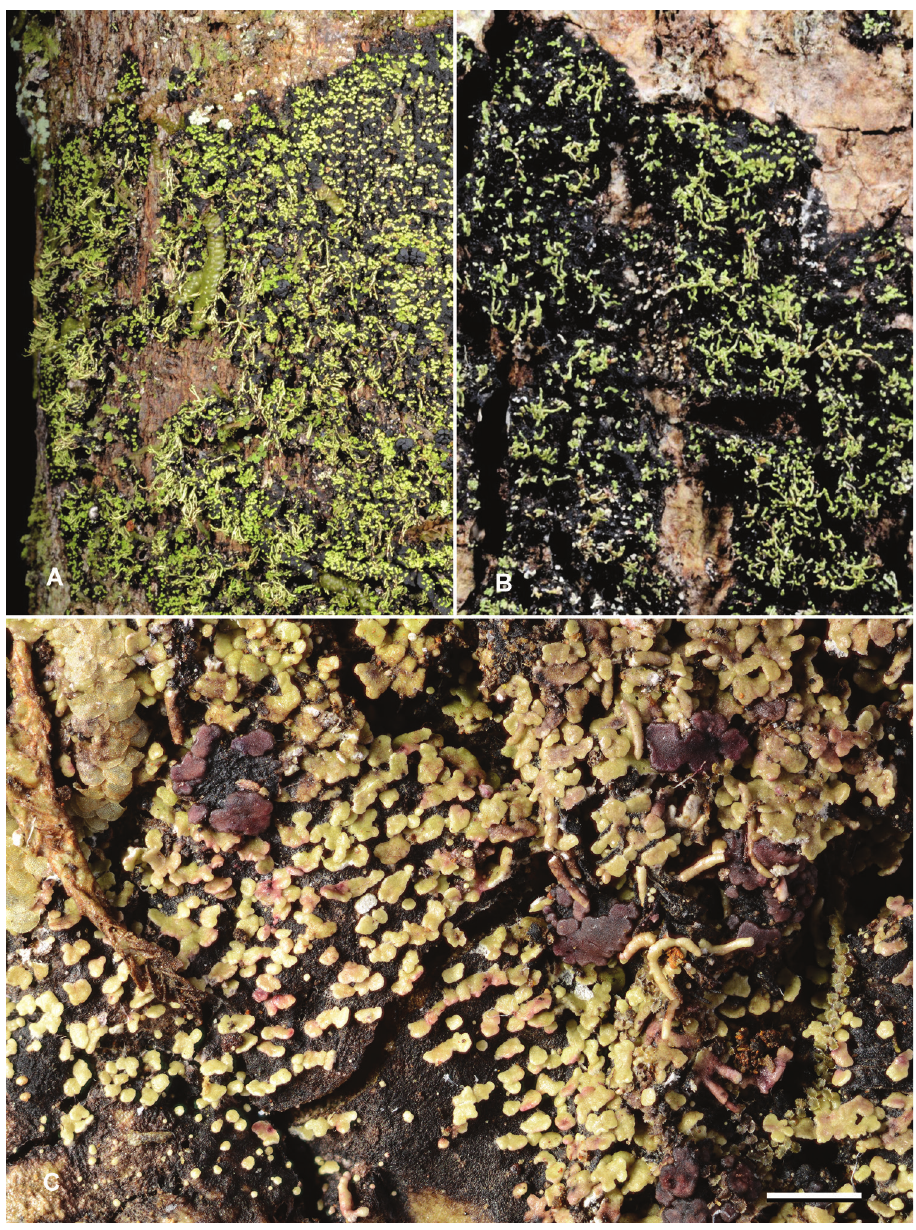
Figure 3. Krogia isidiata. A field photograph of JR35688 B field photograph of JR35034 C herbarium photograph of holotype. Scale bar: 1 mm. Photo: J. Rikkinen ( A, B ), E. Timdal ( C ). light!); algal layer 30–40 µm thick, filled with crystals dissolving in K; medulla com- posed of loosely interwoven hyphae, containing crystals in the upper part; lower cortex lacking; prothallus brownish-black, well developed. Apothecia up to 0.8 mm diam. when simple, often forming aggregates up to 1.6 mm diam., dark reddish-brown